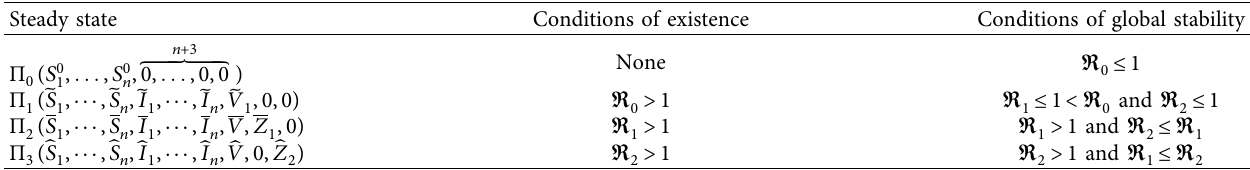
Table 1: Te conditions of existence and global stability for the steady states of model